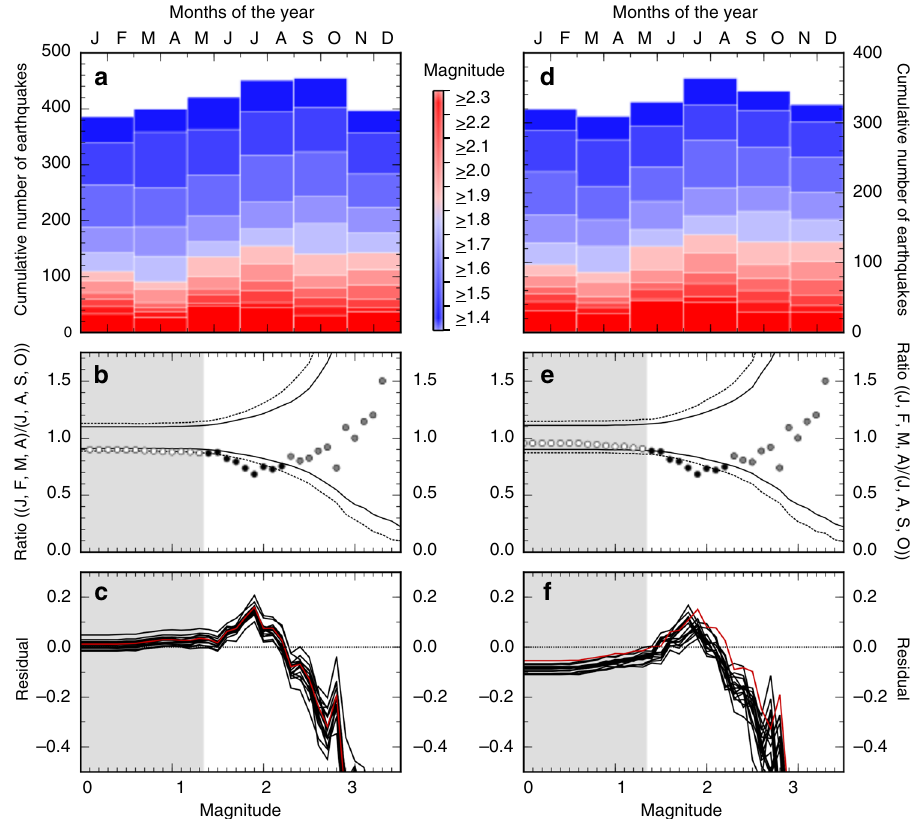
Fig. 3 Analysis of seasonal trends in seismicity around the New Madrid Seismic Zone (NMSZ). a Histogram (in 2-month bins) for the number of earthquakes in the complete catalogue between 1 January 2000 and 31 December 2015 for the entire NMSZ region, as shown in Fig. 1a by the red box. Colours are indicative of the magnitude cut-off used in each case. b Ratio of the number of earthquakes occurring in the 4-month period encompassing magnitude of completeness. Dashed and solid black lines indicate the 99 and 95% con fi dence limits, respectively. Black points are those where the ratio exceeds the 95% con fi dence limit. c Results of a Jack-knife analysis of the seasonal trend. Lines indicate the residual at each magnitude band between the calculated ratio and the 95% con fi dence limit. Red line is for the full catalogue, as shown in b . Black lines are for the same catalogue with successive years of data removed. Con fi dence limits are estimated independently for each test. Grey area again indicates the magnitude of the completeness of the catalogue. d – f are as a – c , but for the seismicity catalogue after